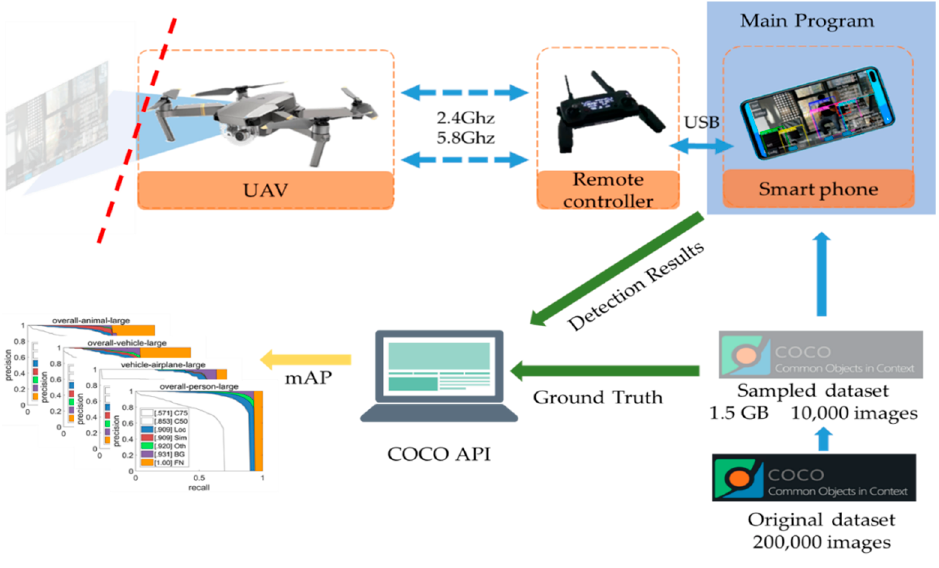
Figure 7. Detection evaluation setup overview.